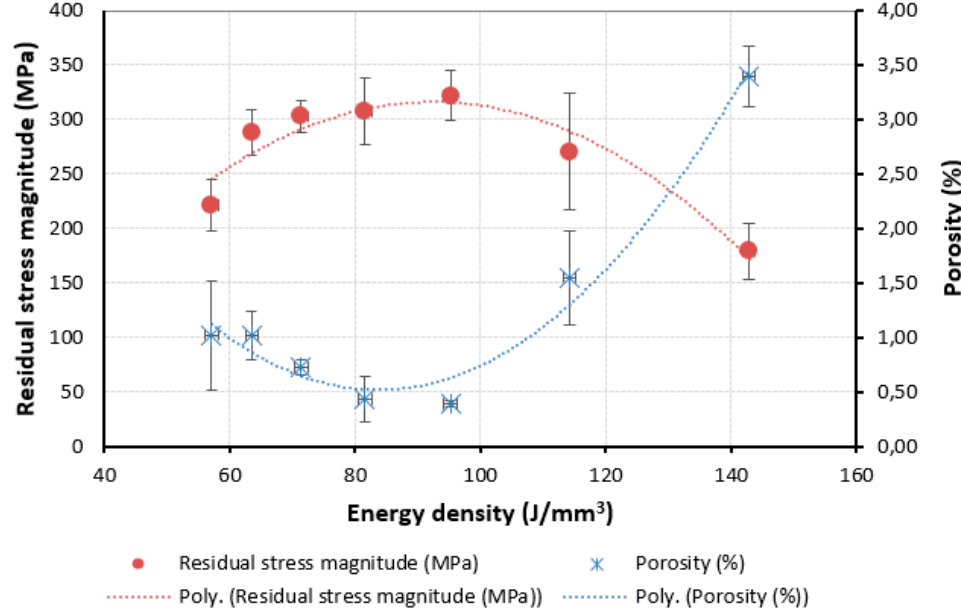
ff ect of energy density on ( a ) porosity and ( b ) residual Figure 13. Effect of energy density on ( a ) porosity and ( b ) residual stresses. Figure 13. E